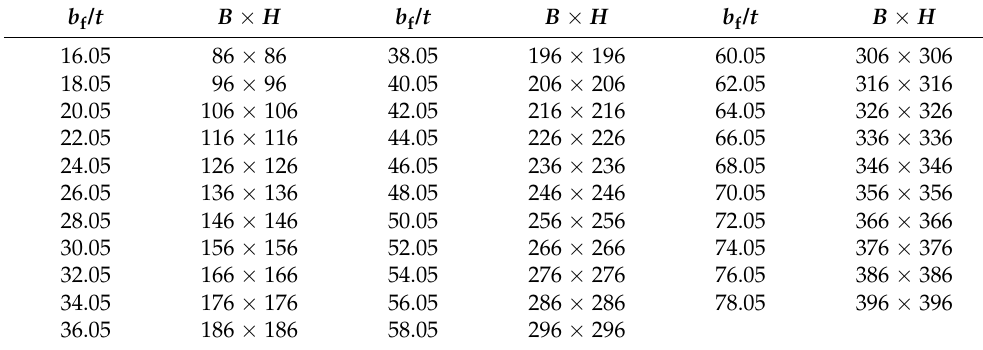
Table 5. Dimensions of HHS honeycomb specimens for parametric analysis ( t = 5, unit: mm). b f / t B ×